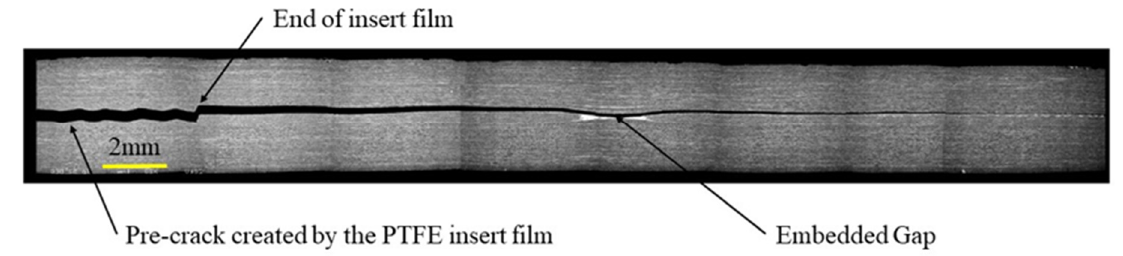
Figure 18. Micrograph Mode II specimen, 6.35 mm gap with caul plate.